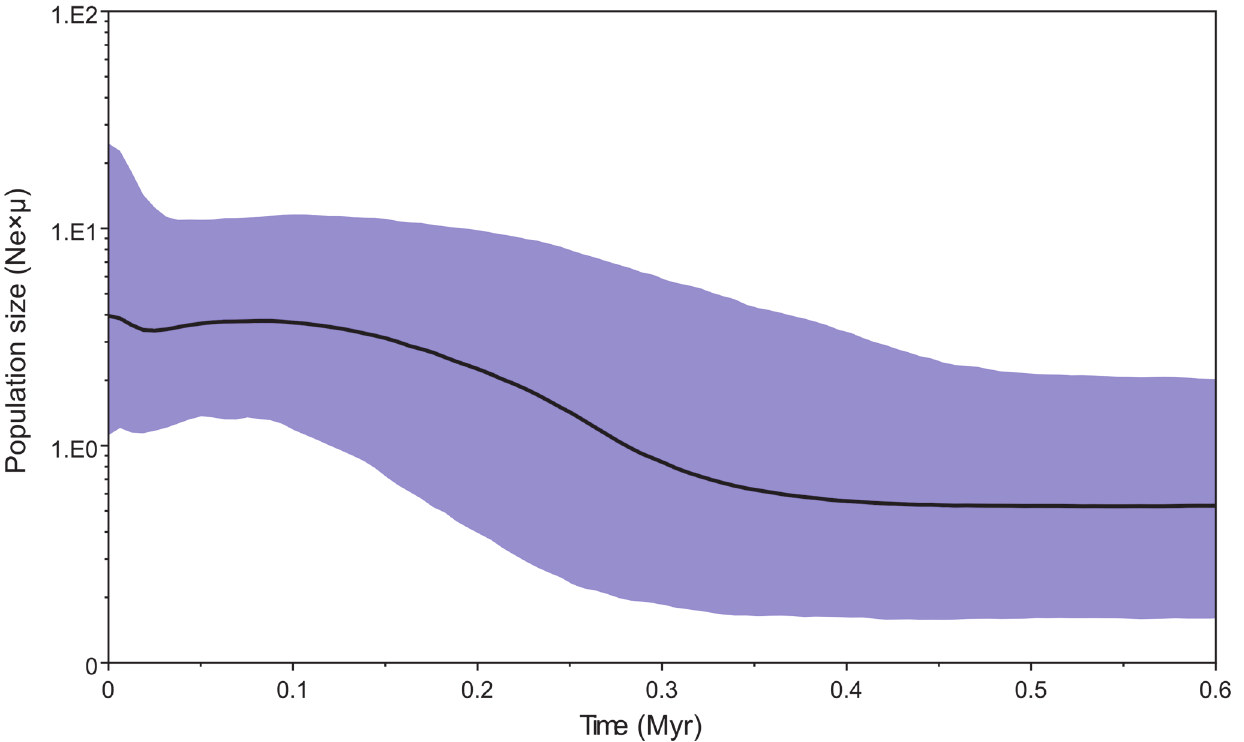
Fig 6. A Bayesian skyline plot derived from an alignment of mtDNA haplotypes of Spirometra erinaceieuropaei isolates in Clade I. The X-axis is in units of million years in the past and the Y-axis is Ne× μ (effective population size × mutation rate per site per generation). The median estimates are shown as thick solid lines, and the 95% HPD limits are shown by the blue